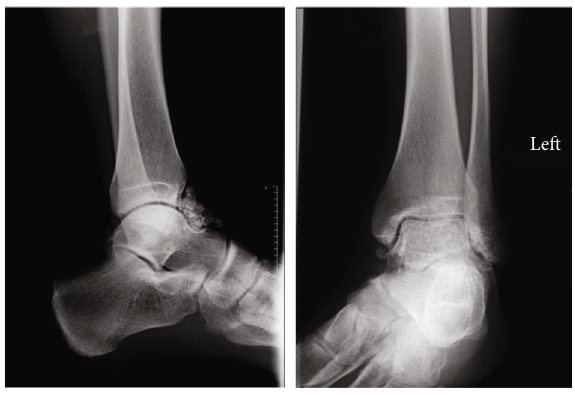
Figure 1: Lateral and mortise views of the left ankle joint on presentation.